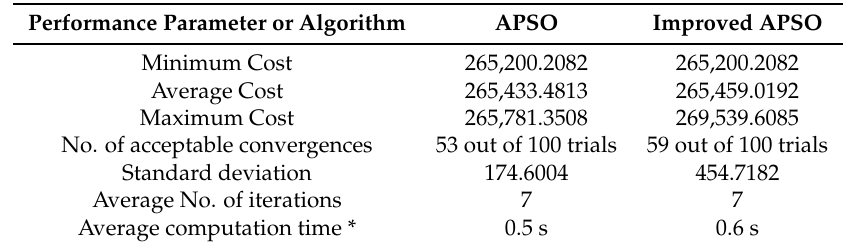
Table 9. Comparison of some performance parameters between APSO and improved APSO on the pumped storage STHTS problem considering valve point loading.